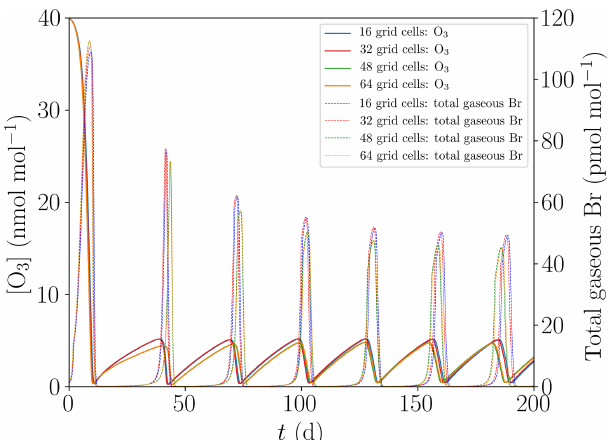
Figure 4. Evolution of O 3 and total gaseous bromine mixing ratios for four different numbers of grid cells of M = 16, 32, 48, and